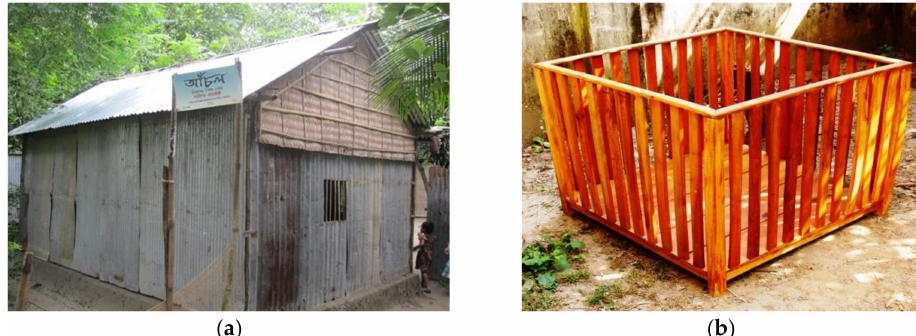
Figure 1. SOLID study interventions: ( a ) day-care intervention; ( b ) wooden playpen. The two sub-districts were divided into two areas, with the villages in those sub-